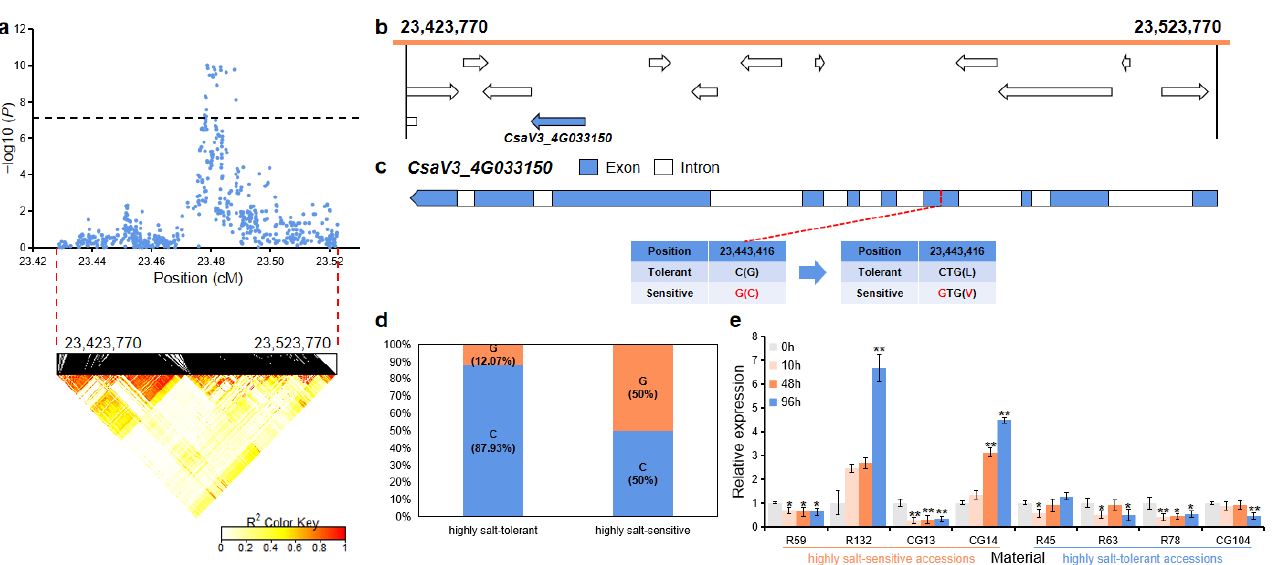
Figure 7. Identification of the candidate gene that was related to salt tolerance for the locus gST4.2 . ( a ) Manhattan plot and LD heatmap of gST4.2 . The black dashed line represents the significance threshold and the red dashed lines represent the candidate region (100 kb). ( b ) A total of 13 func- tional annotated genes were predicted in the gST4.2 candidate region. The blue arrow indicates that the functional annotation of the gene which is related to salt tolerance. ( c ) Gene structure of CsaV3_4G033150 . Blue rectangles and white rectangles indicate exons and introns, respectively. ( d ) Orange and blue blocks represent the proportion of G and C haplotypes in the highly salt-tolerant or highly salt-sensitive accessions, respectively. ( e ) qRT-PCR was used to detect the expression changes of CsaV3_4G033150 in the highly salt-sensitive accessions (R59, R132, CG13, and CG14) and highly salt-tolerant accessions (R45, R63, R78, and CG104) after salt treatment (0 h, 10 h, 48 h,